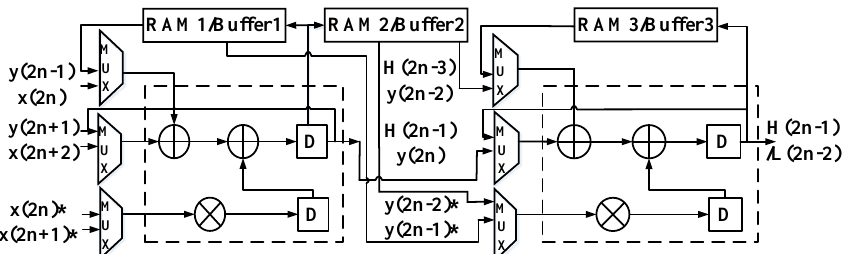
Figure 6. The 1-D DWT structure for the second level. Note: The items with * are the multiplication terms that should arrive ahead of time.